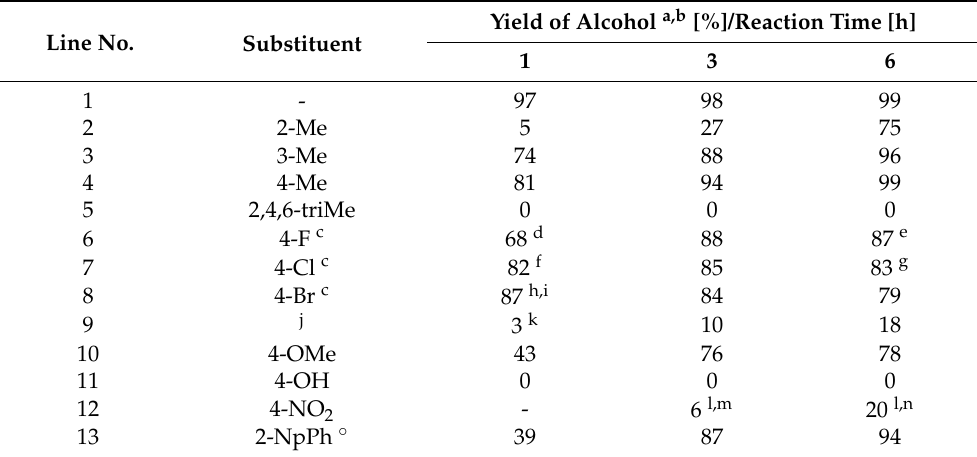
Table 1. Liquid phase transfer hydrogenation of substituted Ph 2 CO with 2-octanol in the presence of MgO